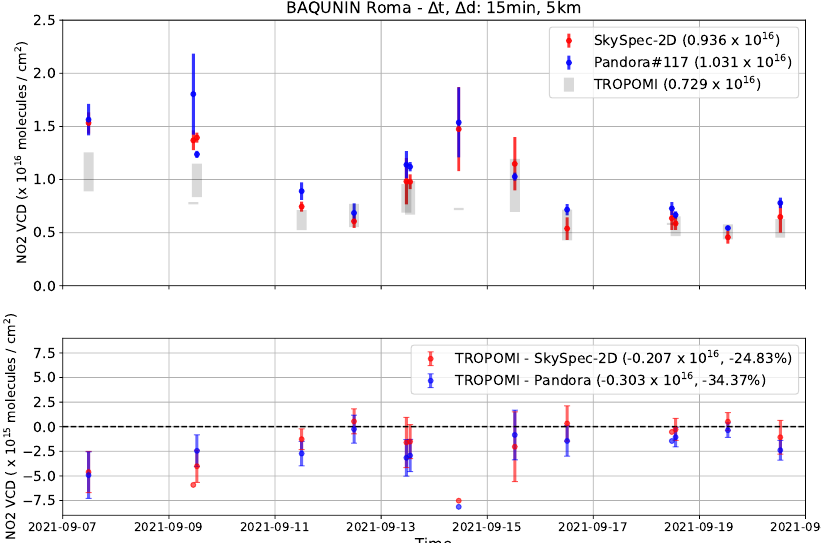
Figure 10. NO 2 VCDs, averaged in 15 min intervals, retrieved from SkySpec-2D (in red) and Pan- dora#117 (in blue), and NO 2 VCDs measured by TROPOMI (grey shadow) during the BAQUNIN inter-comparison campaign. The TROPOMI shadows represent the mean values within the 5 km radius with standard